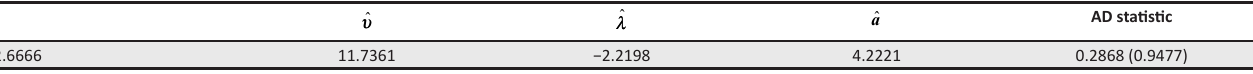
TABLE 5: Maximum likelihood estimates of the Pearson type-IV distribution for the asymmetric power auto-regressive conditional heteroscedastic (1,1)–Pearson type-IV distribution model. m ˆ